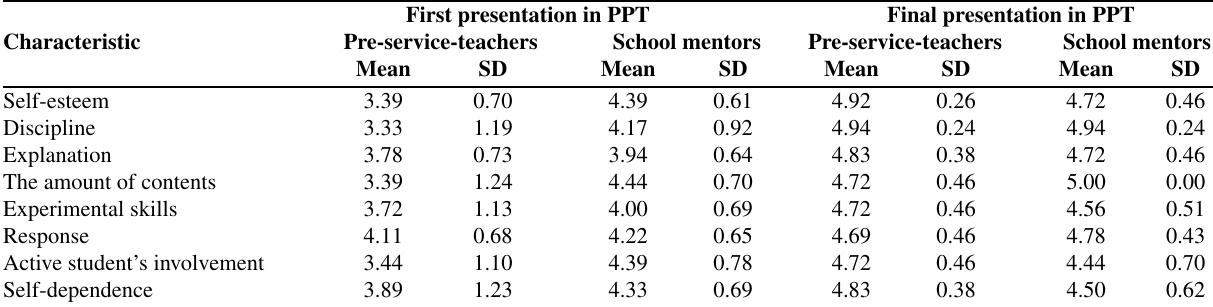
Table 2. The mean values for eight characteristics measured by “Questionnaire for monitoring students’ progress” 7 from student-teachers’ and school mentors’perspectives after their first and final presentation during PPT